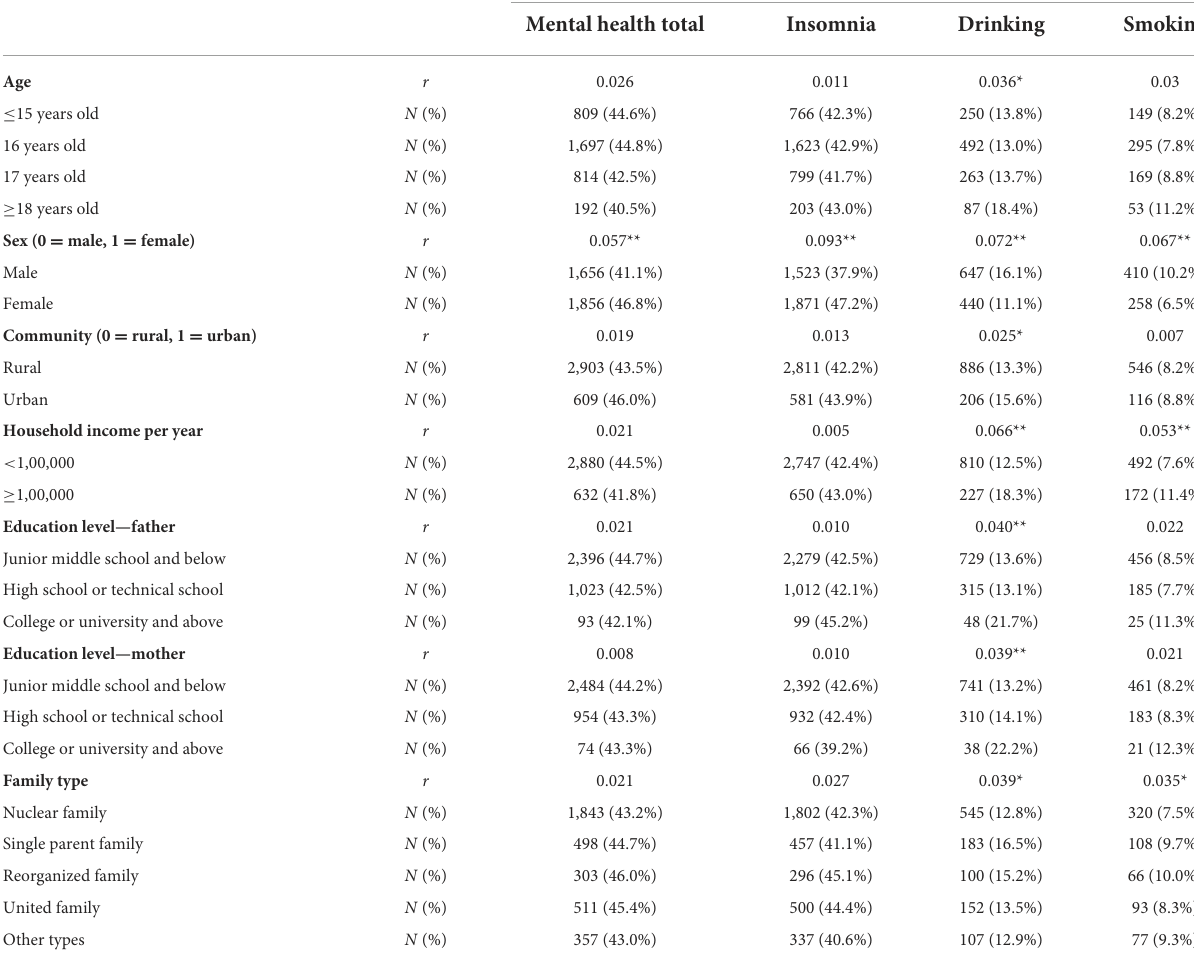
TABLE 4 Tests of associations of student socio-demographic characteristics with behavioral health problems. Socio-demographic characteristics Behavioral health problems Mental health total Insomnia Drinking